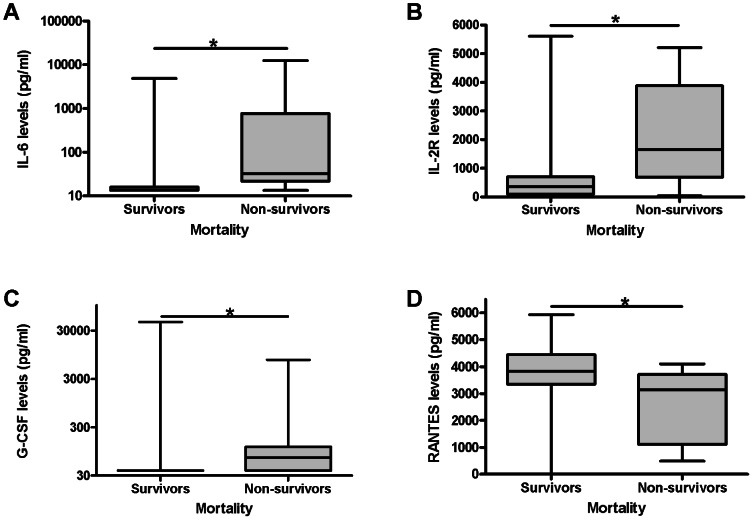
IL-6, IL-8, IL-2R and RANTES are associated with mortality.A: IL-6: Levels are significantly elevated in non-survivors compared to survivors (P<,0,0001). B: IL-2R: Levels are significantly elevated in non-survivors compared to survivors (P = 0,005). C: G-CSF: Levels are significantly elevated in non-survivors compared to survivors (P = 0,001). D: RANTES: Levels are significantly decreased in non-survivors compared to survivors (P = 0,005). Underlined black asterisk = significant difference between two groups. The Mann-Whitney U test was used to compare the groups with each other.